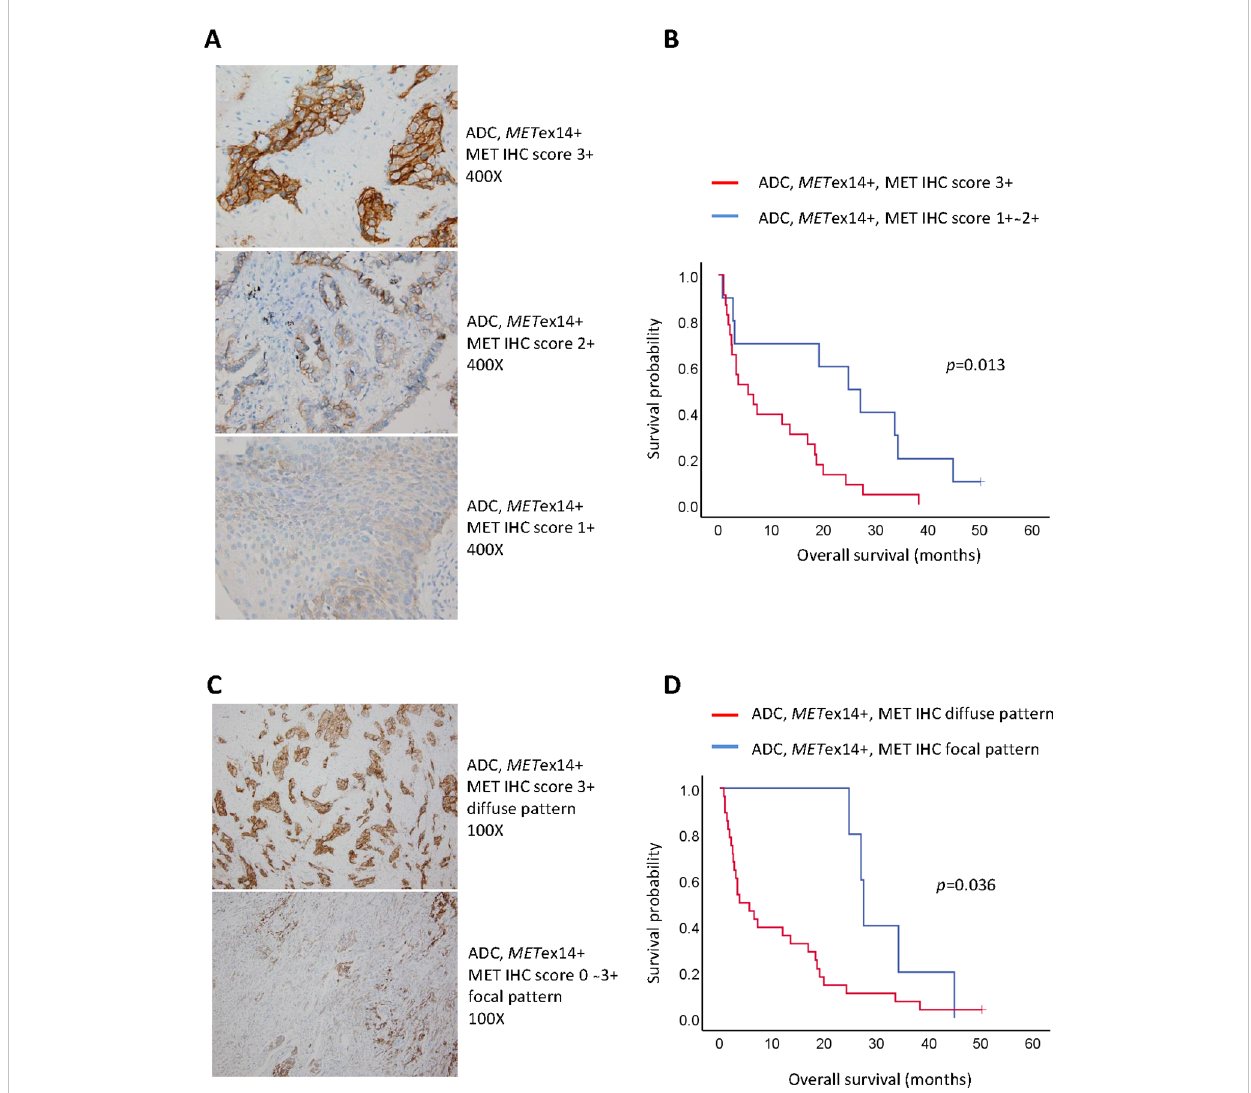
FIGURE 2 Pathological factors associated with poor prognosis in stage IV lung adenocarcinoma harboring MET ex14 ( MET ex14+). (A) Representative fi gures of c-MET immunohistochemistry staining score 3+ (upper panel; original magni fi cation: 400x), score 2+ (middle panel; original magni fi cation: 400x), and score 1+ (lower panel; original magni fi cation: 400x); (B) Kaplan-Meier curves of overall survival for score 1+ ~ 2+ and score 3+; (C) Representative fi gures of c-MET immunohistochemistry distribution patterns ― diffuse pattern (upper panel; original magni fi cation: 100x) and focal pattern (lower panel; original magni fi cation: 100x); (D) Kaplan-Meier curves of overall survival for diffuse and focal